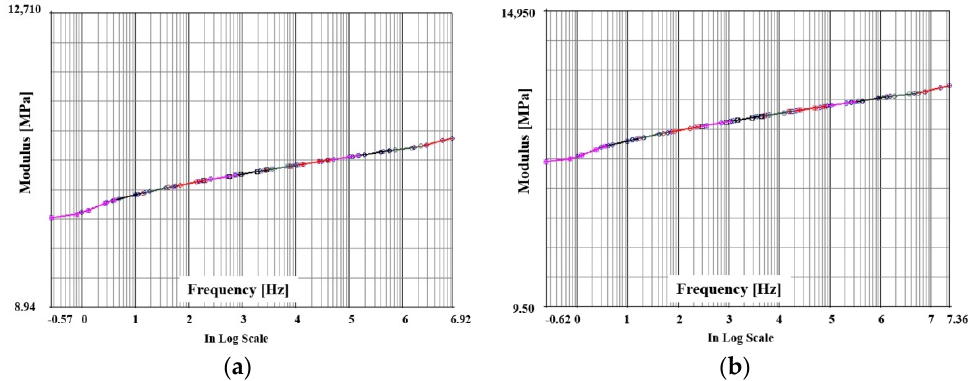
Figure 12. Master curve of PPG after cured as a function of frequency: ( a ) x direction; ( b ) y direction.